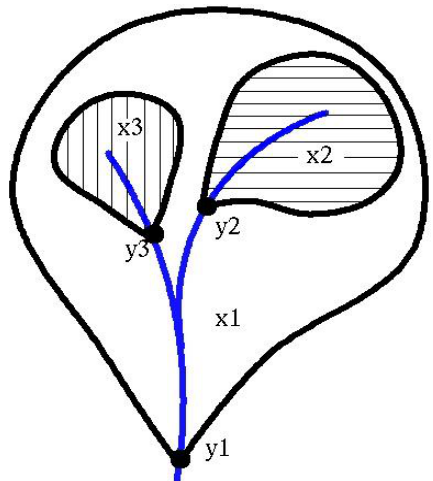
Fig. 3. Simple representation of a basin with its three internal independent sub-basins. The subscript 1 is for the base sub-basin/station streamflow, 2 and 3 stand for the upstream sub-basins/station streamflows. y i is for the streamflow at the gauge station i , and x i represents the variable state (calculated according to the chosen method), excluding the surfaces belonging also to a sub-basin located upstream of it (i.e. x 1 only includes the non-shaded area, x 2 the horizontally shaded area, and x 3 the vertically shaded area).